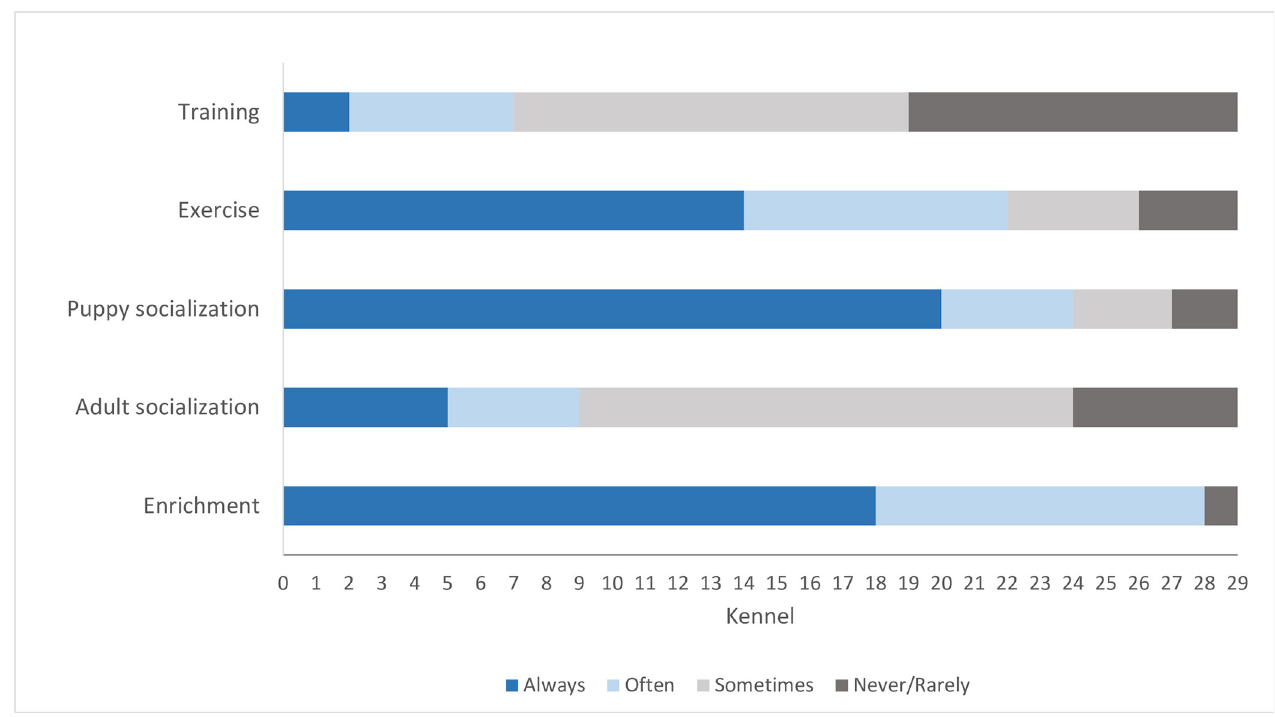
Fig 4. Management practices. Number and frequency of kennels performing specific behavioral management